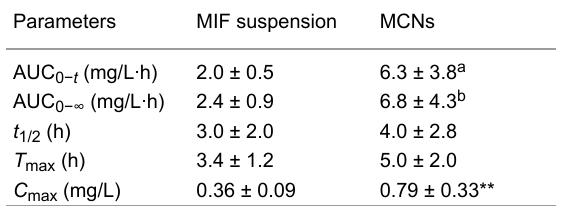
Table 1: Pharmacokinetic parameters of different MIF formulations.